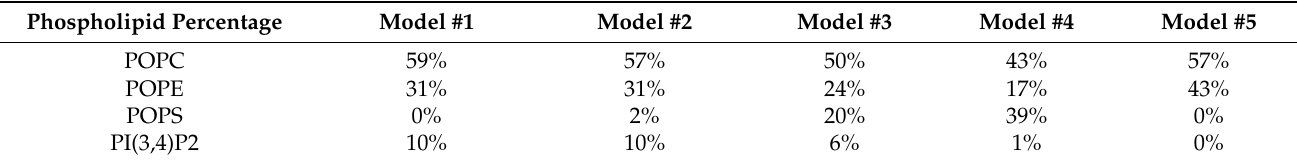
Table 1. Membrane lipid compositions of the outer mitochondrial membrane